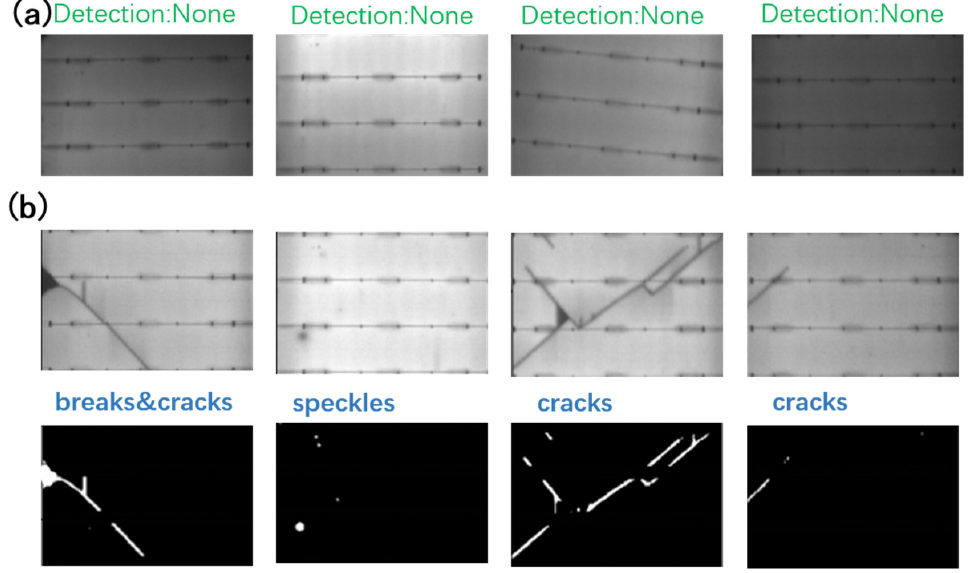
Figure 6. ( a ) Defect-free samples, the method is robust for illumination variations among different samples; ( b ) detected defects and located pixels.